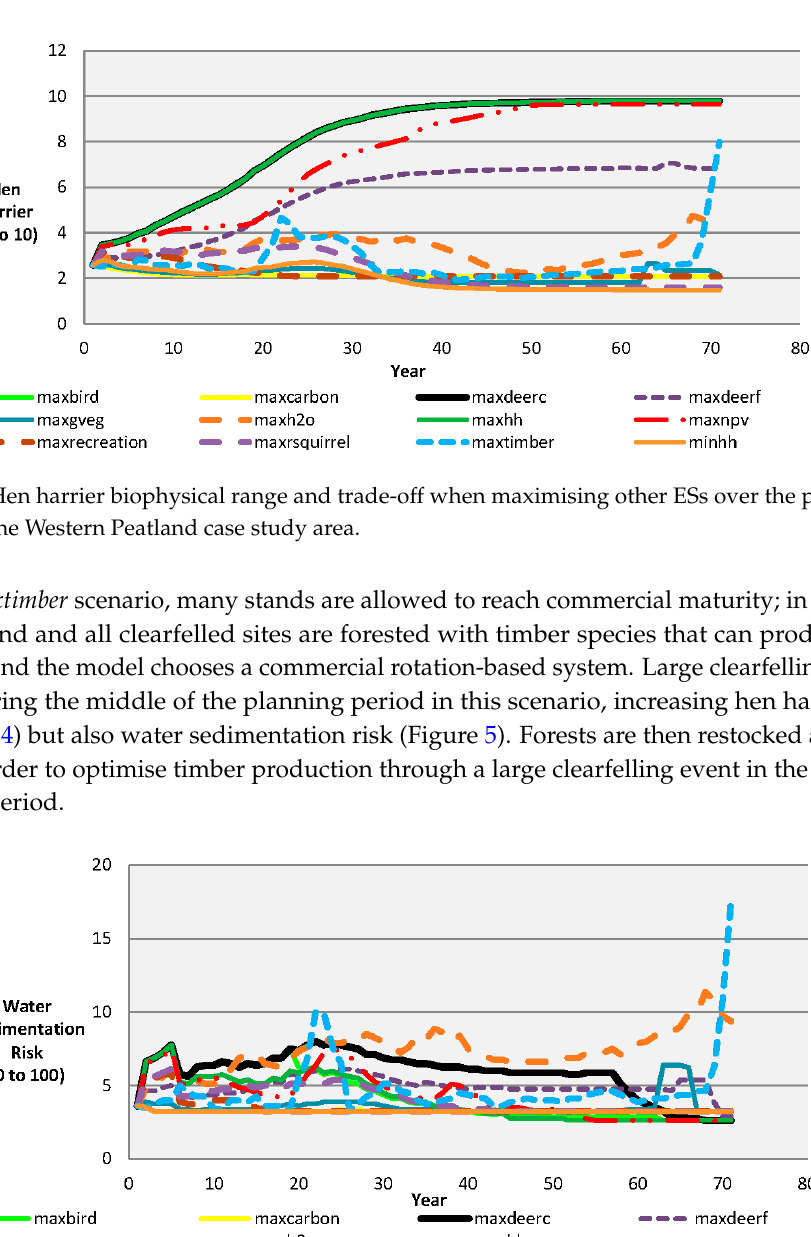
Figure 5. Water sedimentation risk biophysical range and trade-off when maximising other ecosystem services over the planning period in the Western Peatland case study area. Maxcarbon and maxrecreation follow a similar trend to minh2o.